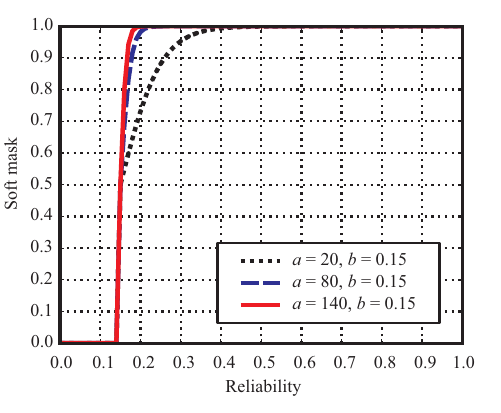
Figure 2. Sigmoid function (Eq.(10) for soft mask generation when b = 0.15 and a = 20, 80, 140.